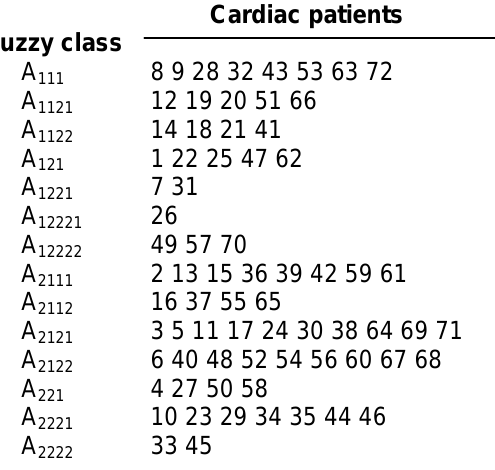
Final Fuzzy Partition of the Cardiac Patients,